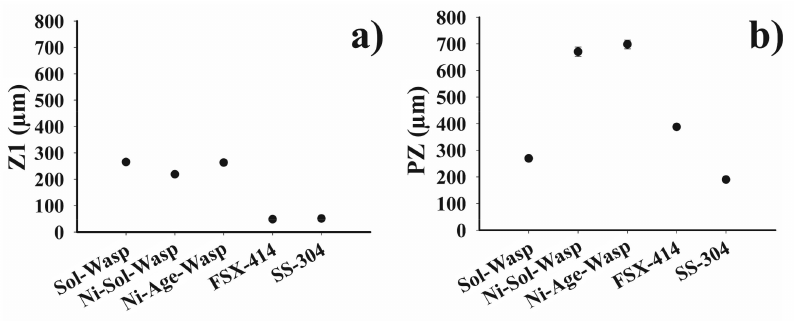
Figure 11. Graphs of the average thickness of the two zones in the brazed alloys: ( a ) Z1 and ( b )